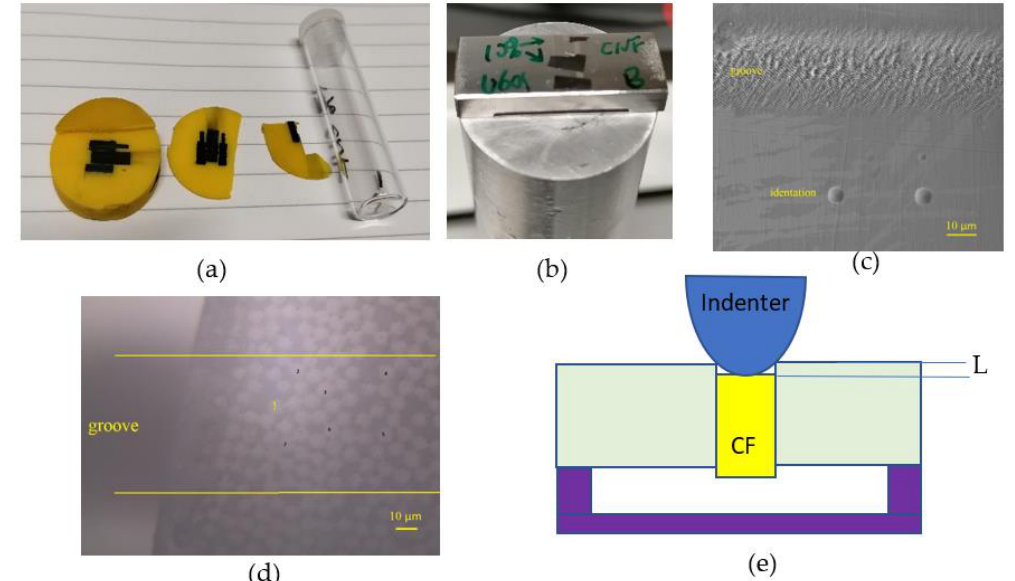
Figure 3. Composite specimen preparation ( a ) pieces cut from mounted samples, ( b ) specimens mounted on the sample holder, ( c ) the round indentations and the groove, ( d ) optical microscopy image of the specimen, and ( e ) schematic of push-out test.